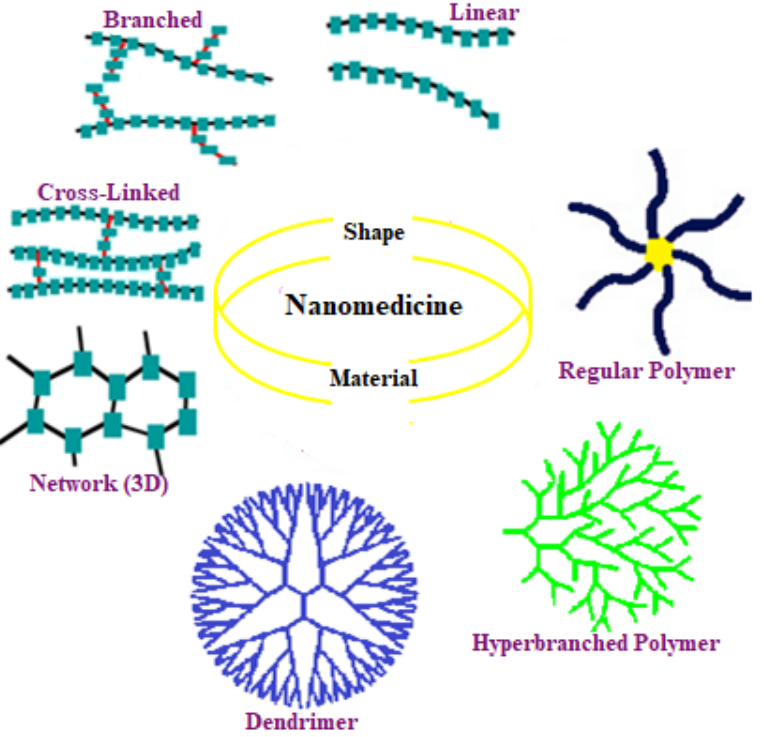
Figure 4. Classification of polymers by molecular topology.